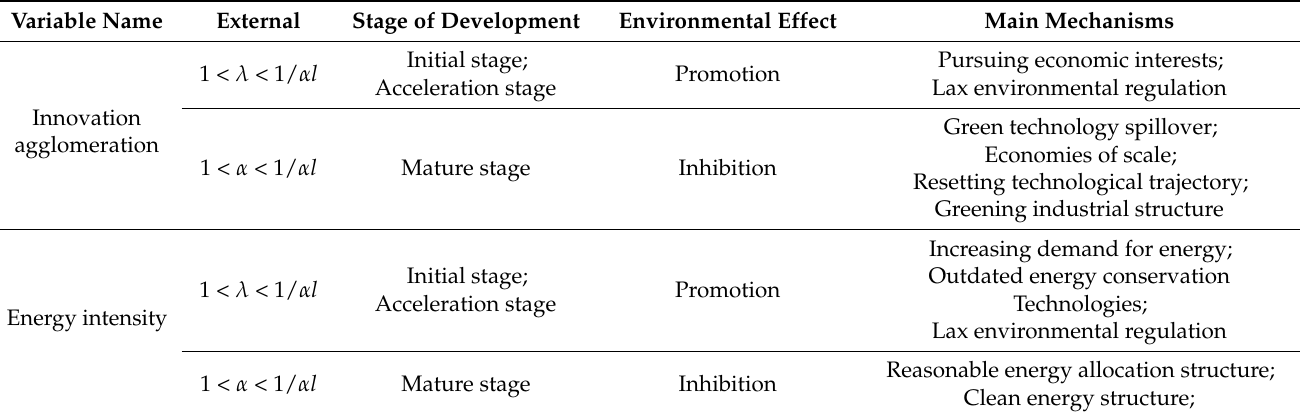
Table 1. Influences of innovation agglomeration and energy intensity on carbon emission intensity under different external